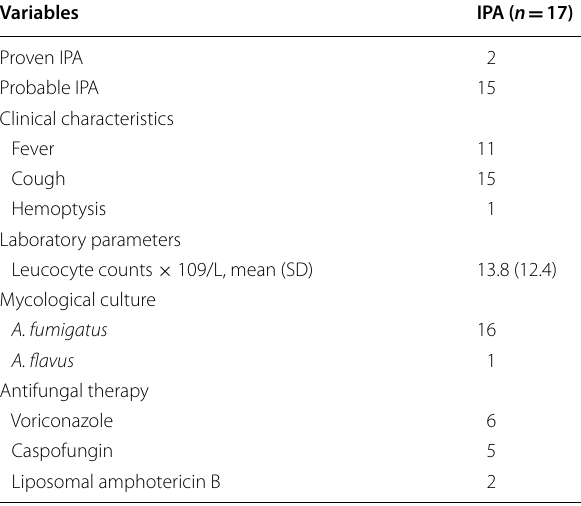
Table 3 Clinical, laboratory parameters finding